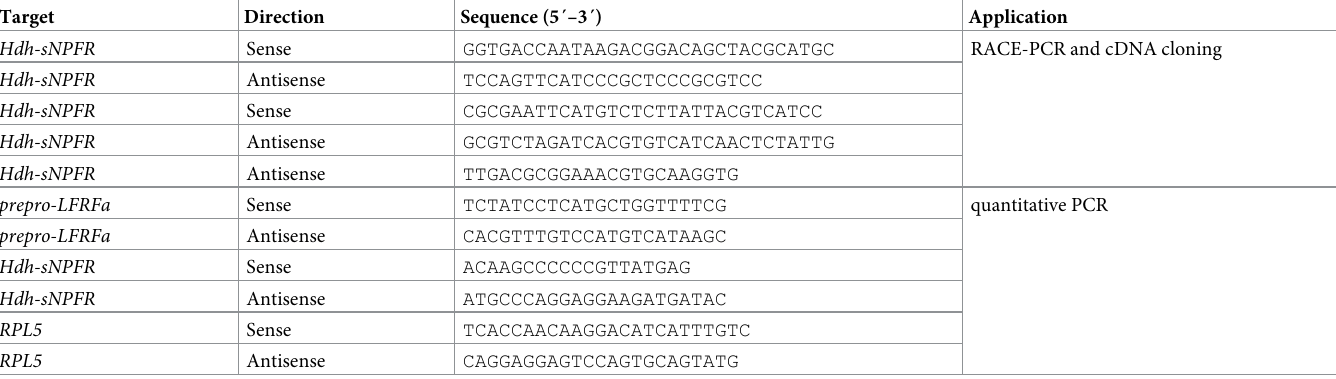
Table 1. Oligo primer sequences used in polymerase chain